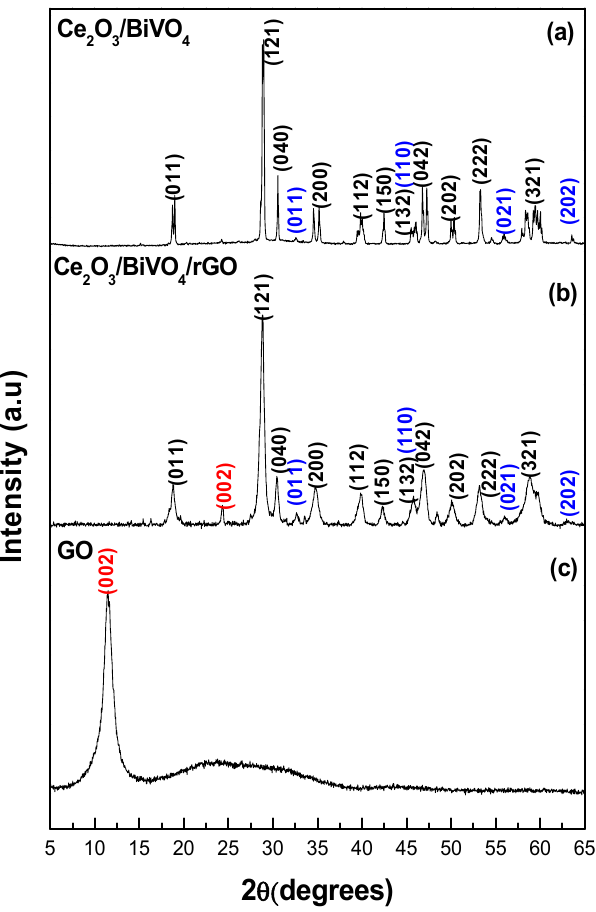
Figure 1. XRD pattern ( a ) Ce 2 O 3 /BiVO 4 , ( b ) Ce 2 O 3 /BiVO 4 /rGO composite. (Black—bismuth vanadate; Red—graphene oxide; Blue—cerium oxide) and ( c ) graphene oxide.